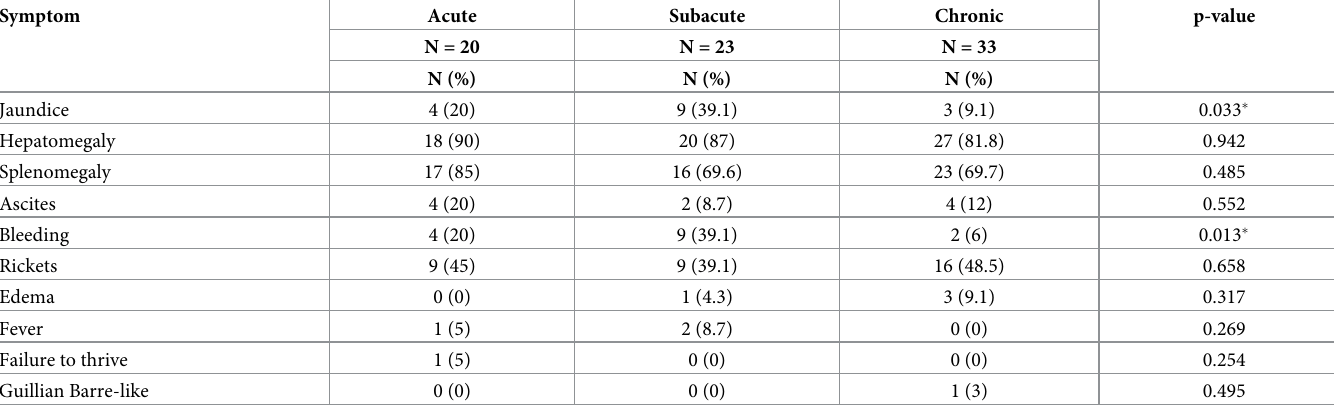
Table 1. Presenting symptoms in 76 hepatorenal tyrosinemia cases according to age of onset of symptoms.